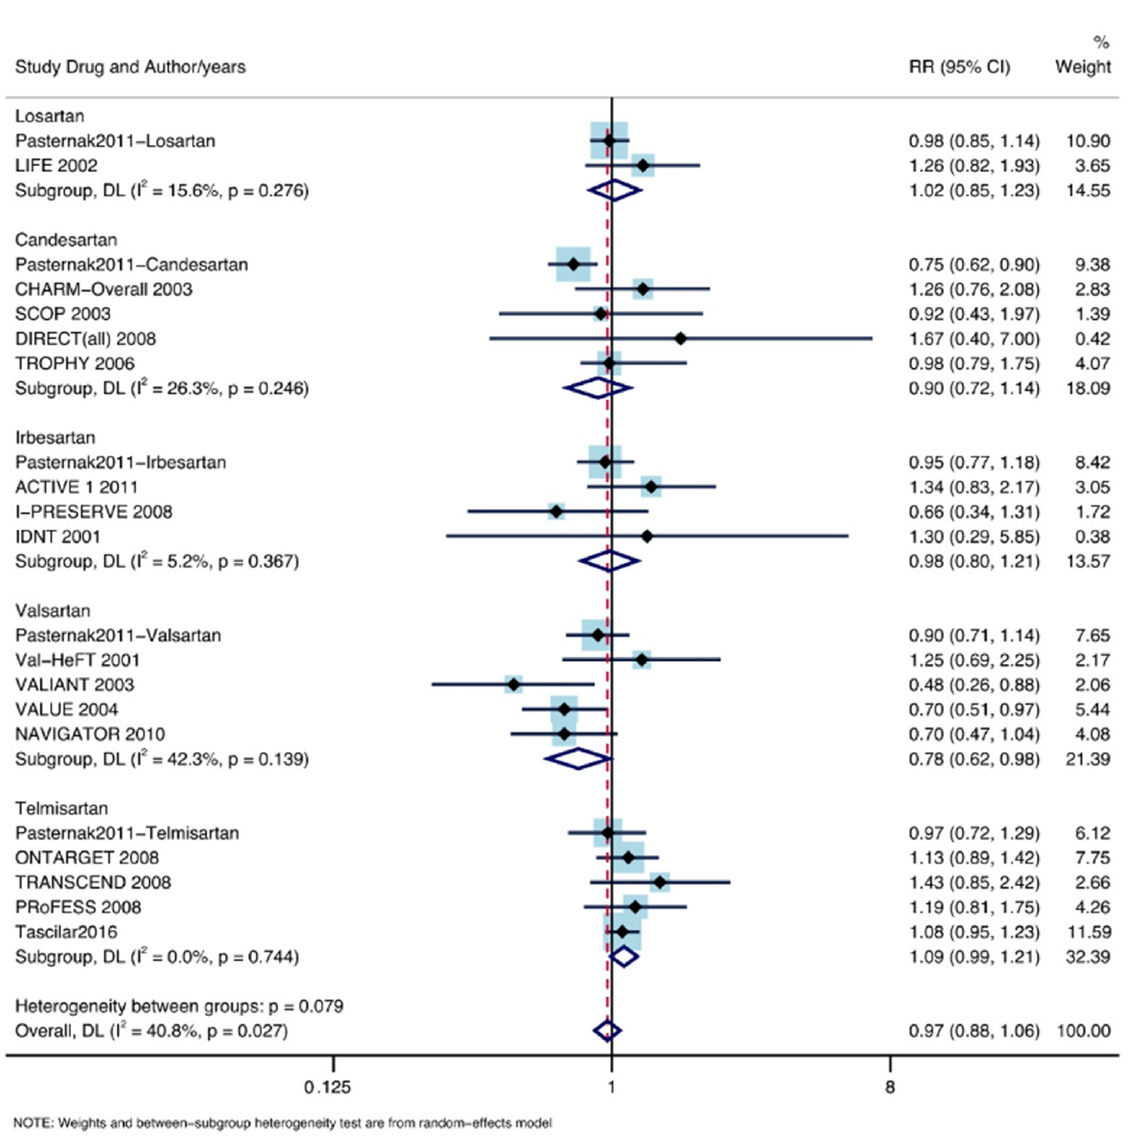
Figure 7. Subgroup analysis by different ARB drugs.